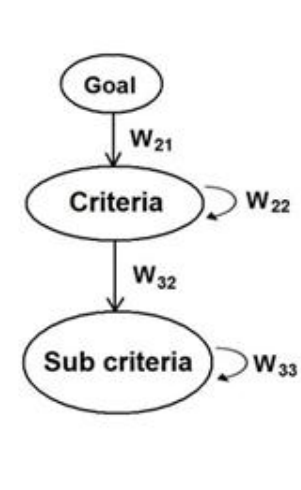
Fig. 5: The relationship between criteria and sub-criteria based on the ANP